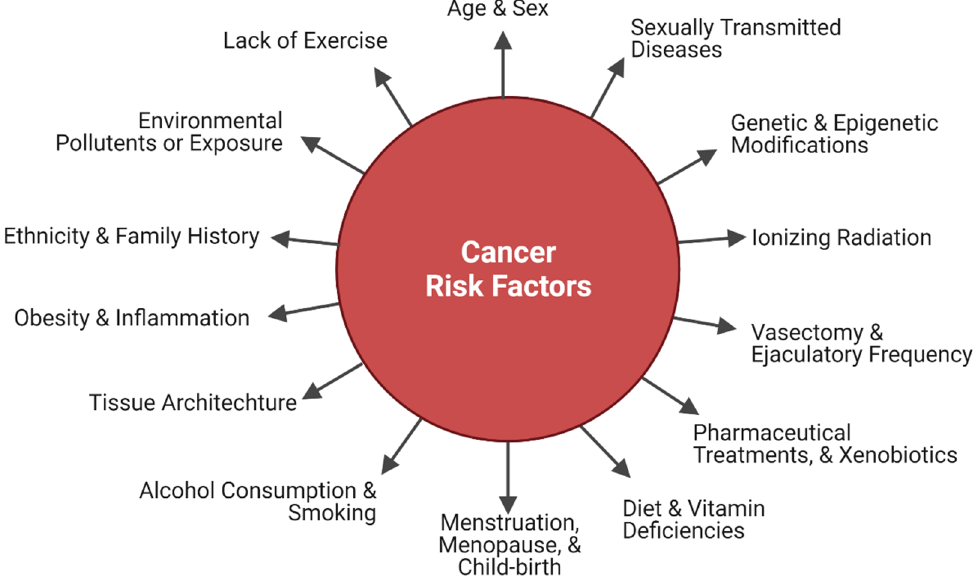
Figure 5. Cancer risk factors. There are multiple risk factors for breast and prostate cancer. Risk factors are either modifiable risk factors (e.g., diet, physical activity, and lifestyle related factors), or not (e.g., genetics, ethnicity, family history, and age).